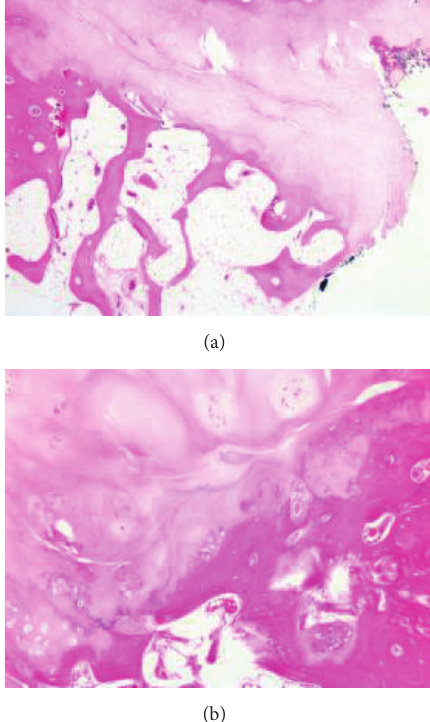
Figure 3: (a) Hematoxylin-eosin stain, original magnification × 2.5, and (b) Hematoxylin-eosin stain, original magnification × 10. Junction of cartilage cap and underlying bone without atypia and resemblance to an epiphyseal plate with enchondral